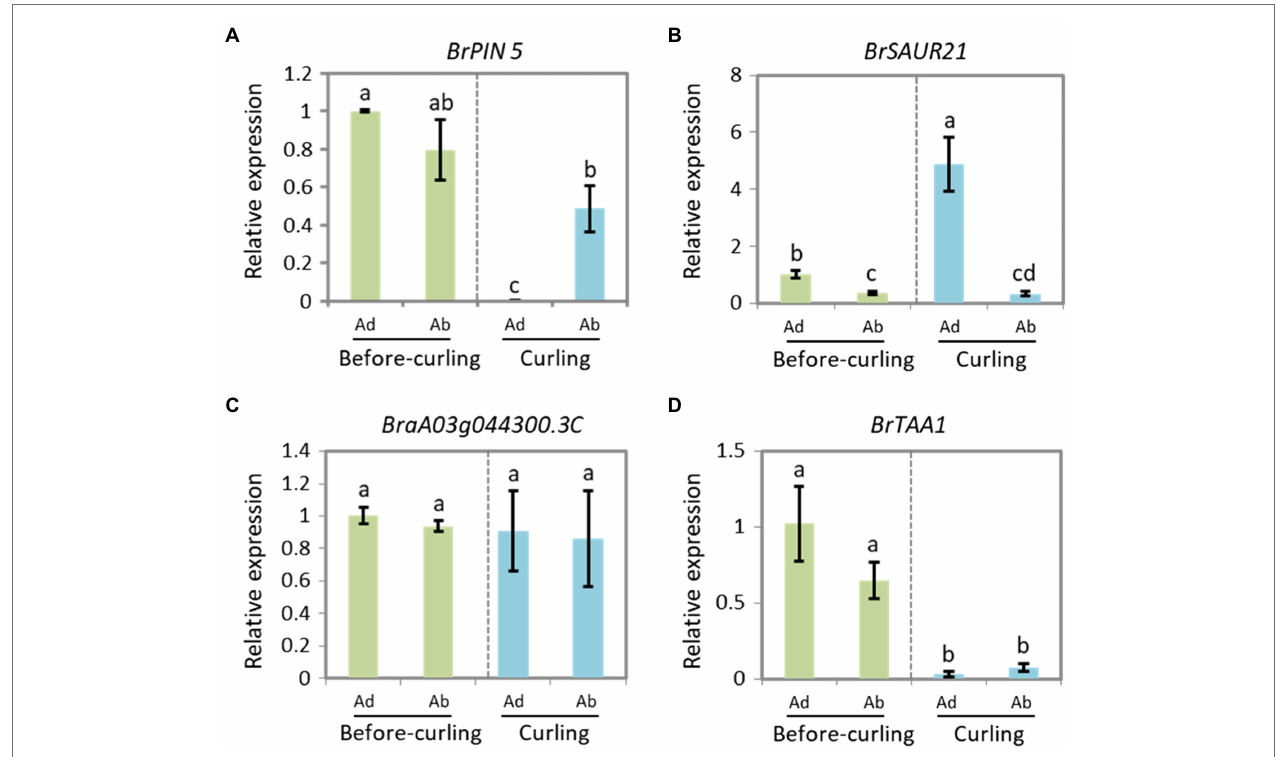
FIGURE 6 | Expressions of BrPIN5 (A) and BrSAUR21 (B) , as well as BraA03g044300.3C (C) and BrTAA1 (D) in abaxial and adaxial midribs of before-curling and curling